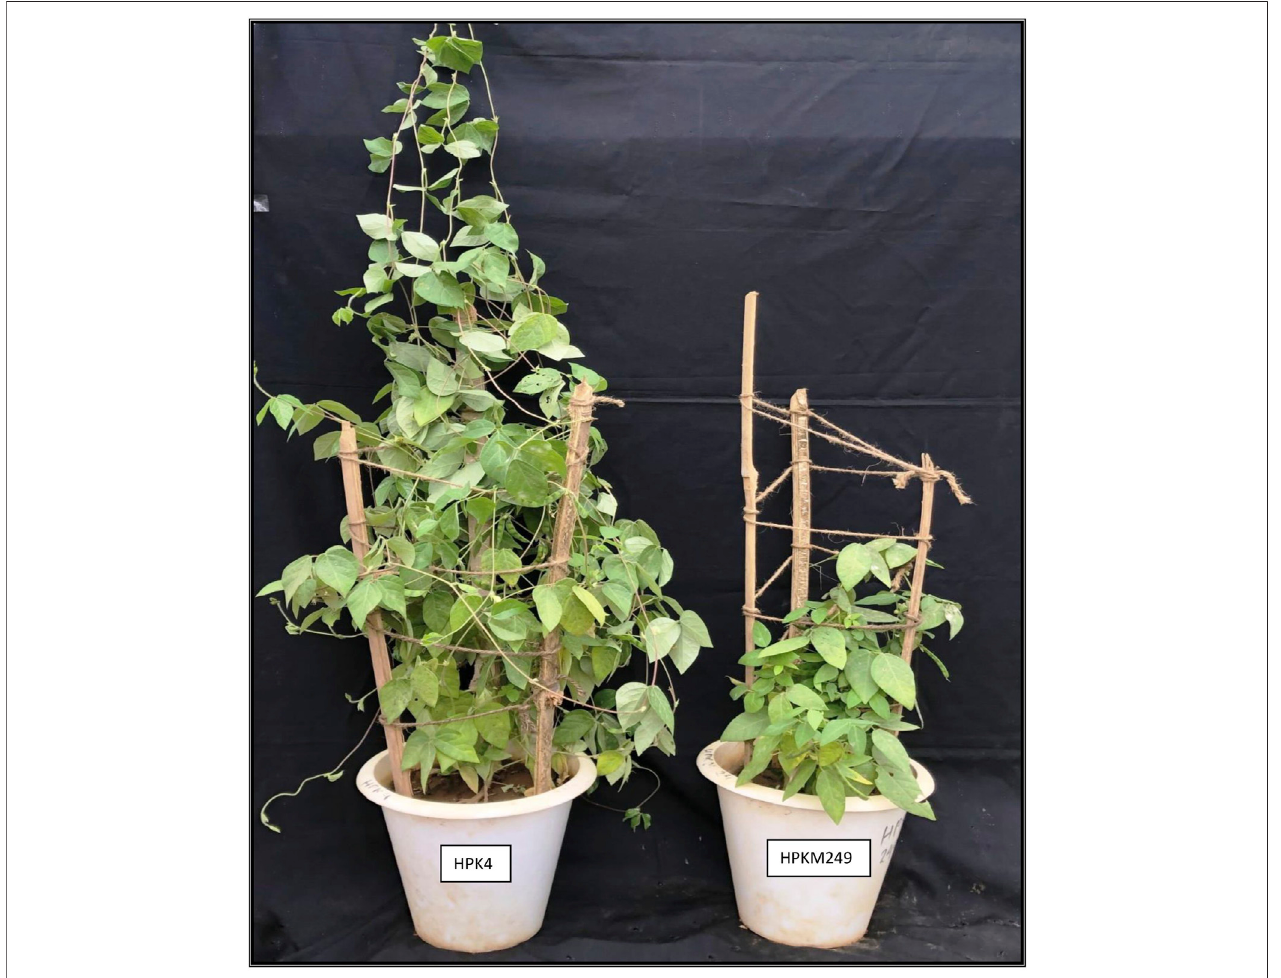
FIGURE 1 | Morphology of the two contrasting parents.